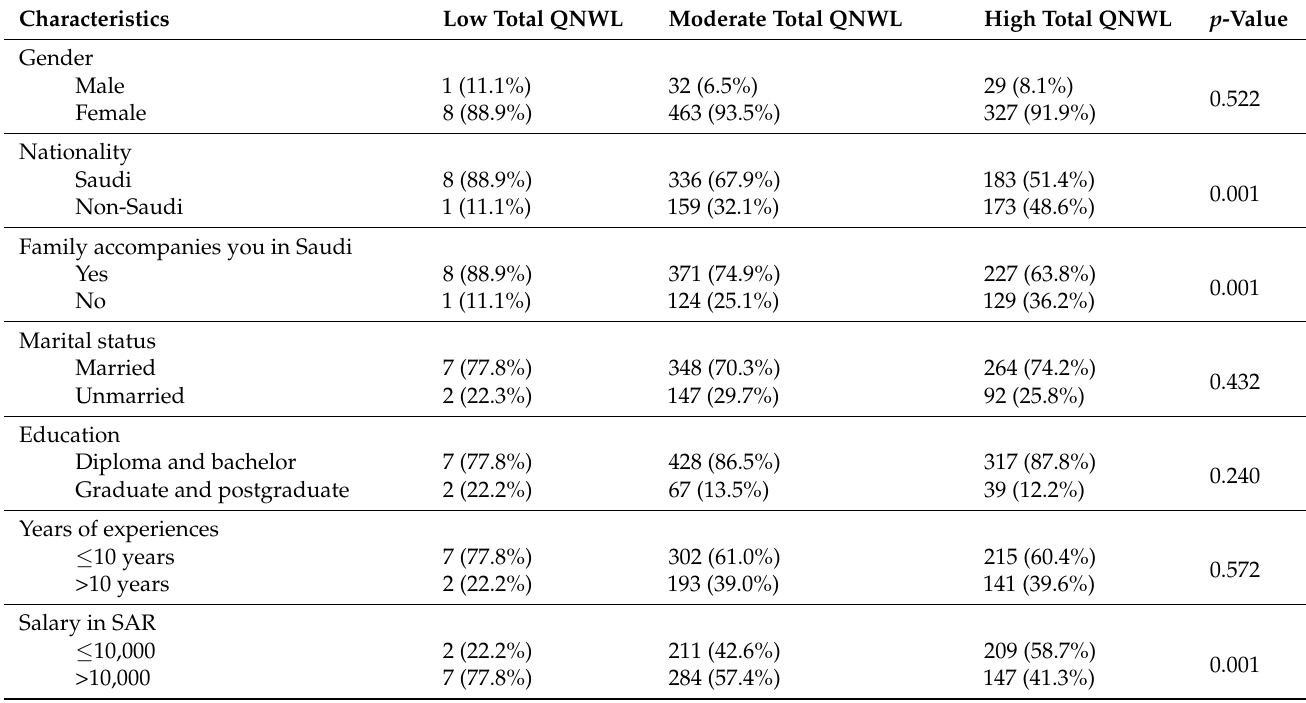
Table 3. The relationship between total QNWL and basic characteristics ( n =